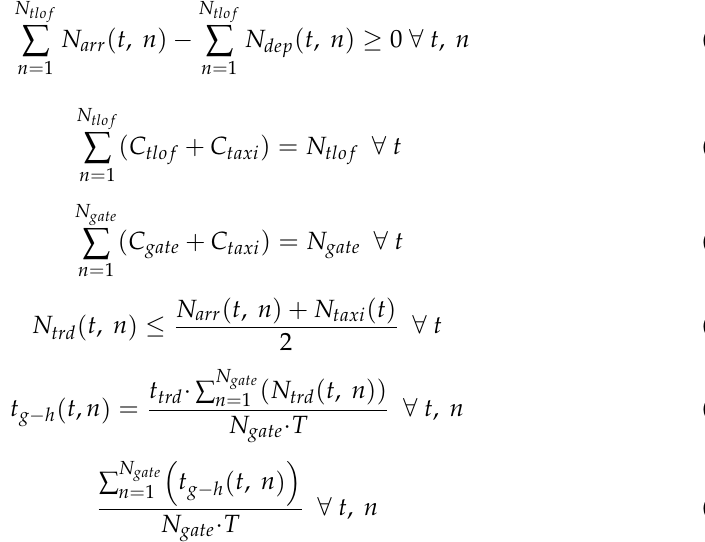
Table 4. Dimensions and slope of obstacle limitation surfaces for all visual FATOs [15].